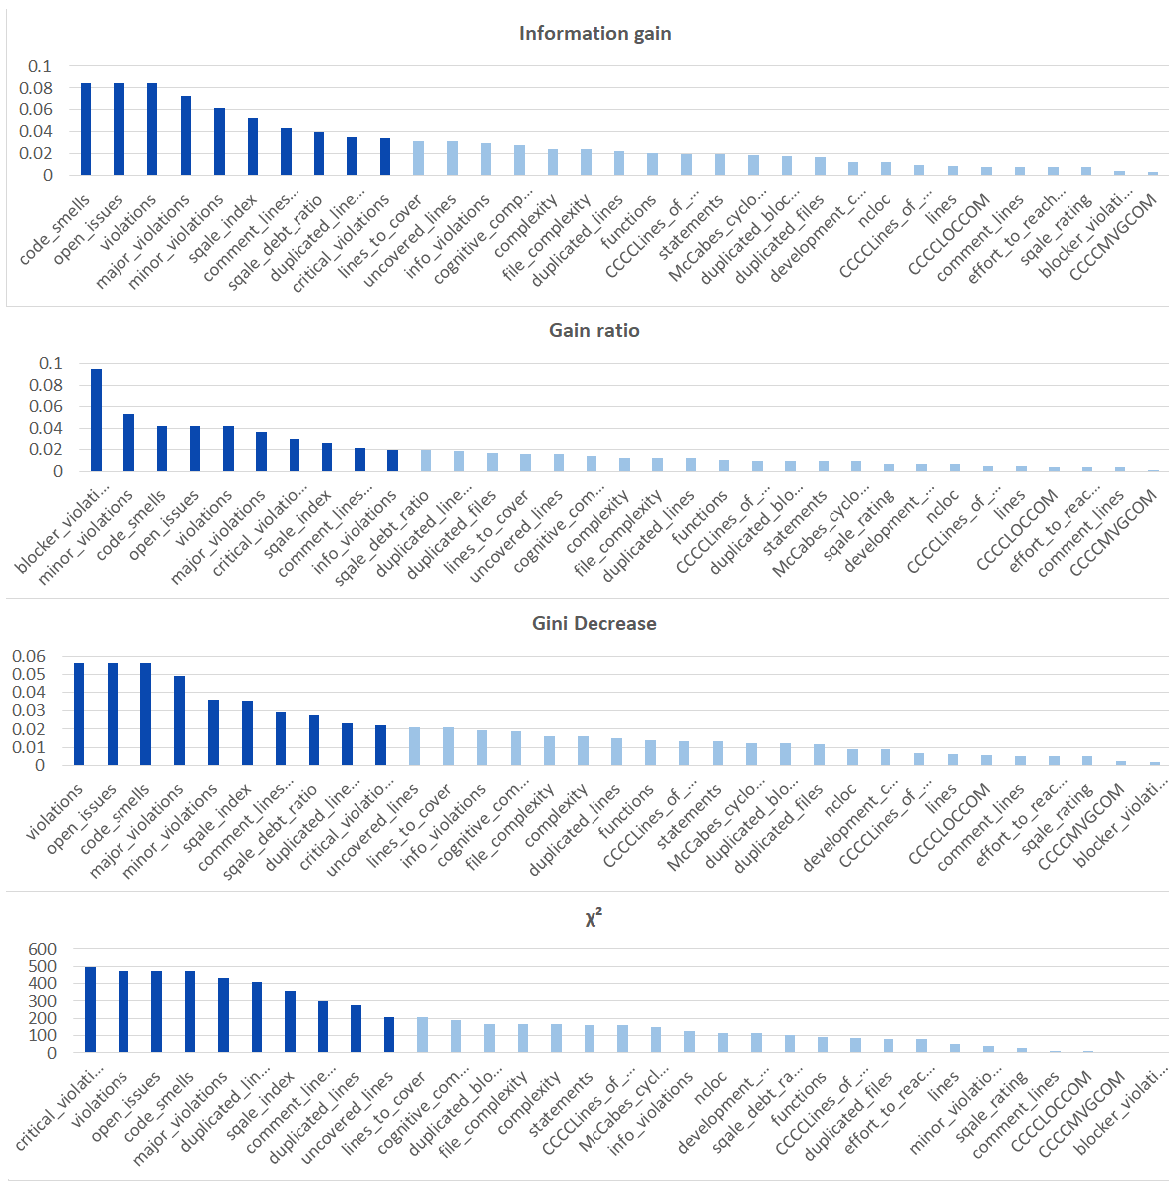
Figure 4. Feature ranks obtained using different types of metrics for the whole